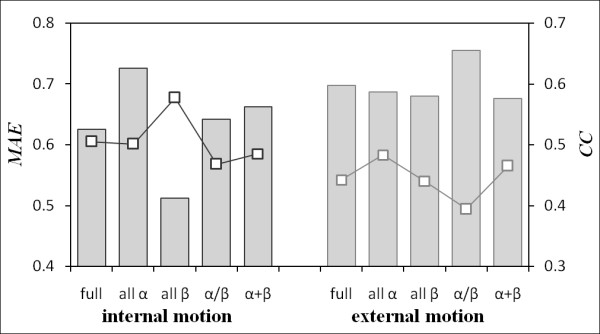
Prediction accuracy according to SCOP classification. Squares and bars respectively show the agerage of MAEs and CCs. Herein, full includes the full dataset; it is equal to the score shown in Table 1. The plot shows MAE, and the histogram shows the average of CCs. These results were obtained using the method that implemented psipred and sable.